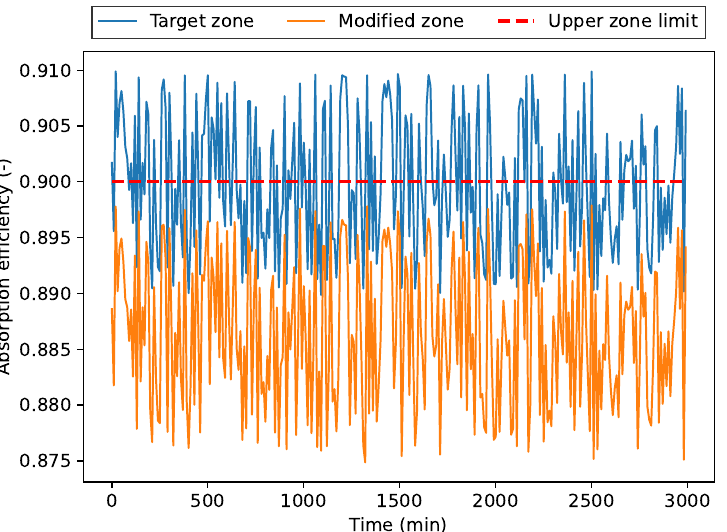
Figure 3. Trajectories of the absorption efficiency (y) for the absorption column under the operation of the zone EMPC control algorithm tracking the original target zone (blue) and modified zone (orange). Target zone: EMPC tracking the target zone; Modified zone: EMPC tracking the modified zone; Upper zone limit: upper bound of the target